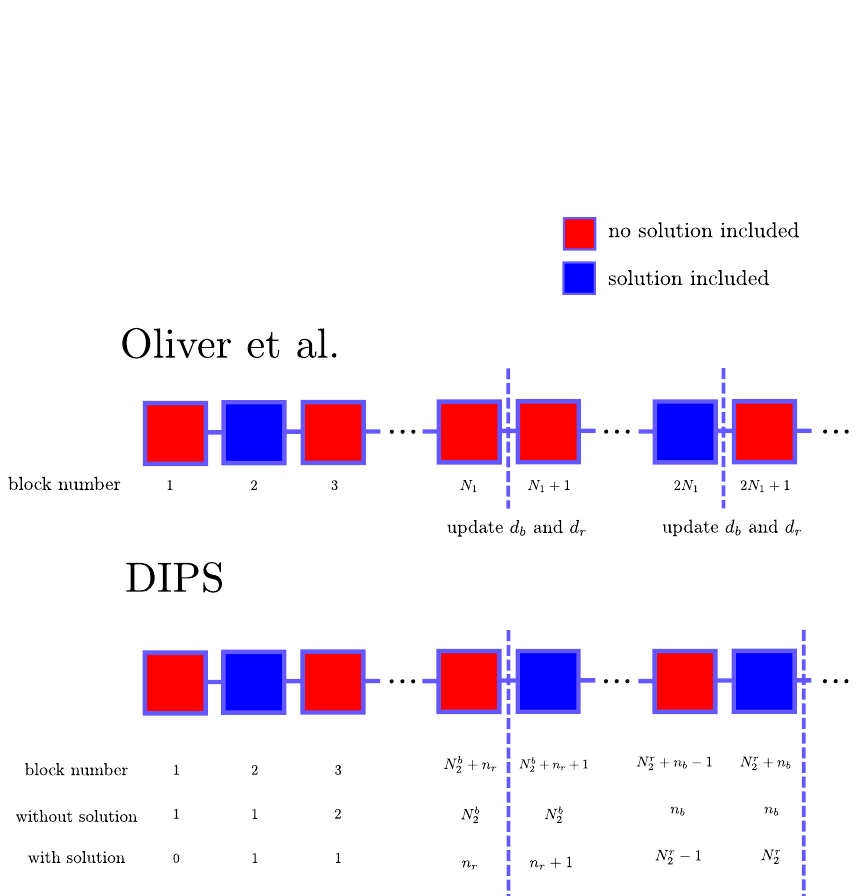
Fig. 1. Schematic depicting the difference between a blockchain with proof-of-work protocol Oliver et al. and DIPS. The red blocks are standard blocks that do not contain a solution to a problem (classical blocks), while the blue blocks contain a solution that results in a score that is better than the current best score of P (solution blocks). In Oliver et al. both d b and d r are updated every N 1 blocks. In DIPS, d b is updated every N b blocks that do not contain a 2 solution to a problem and d r is updated every N r blocks that do contain a solution. n r and n b 2 are arbitrary